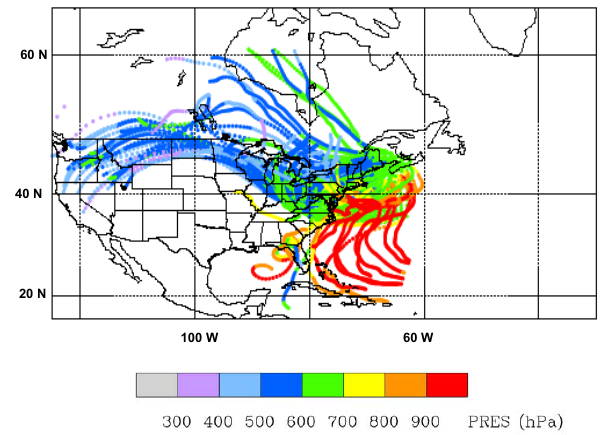
Fig. 14. HYSPLIT 4-day back trajectory matrix based on EDAS 40km meteorological data initiated from area of enhanced 681hPa TES CO observations at 1700 UTC June 15, 2005. The colors indi- cate the altitudes of the trajectories in pressure (hPa).